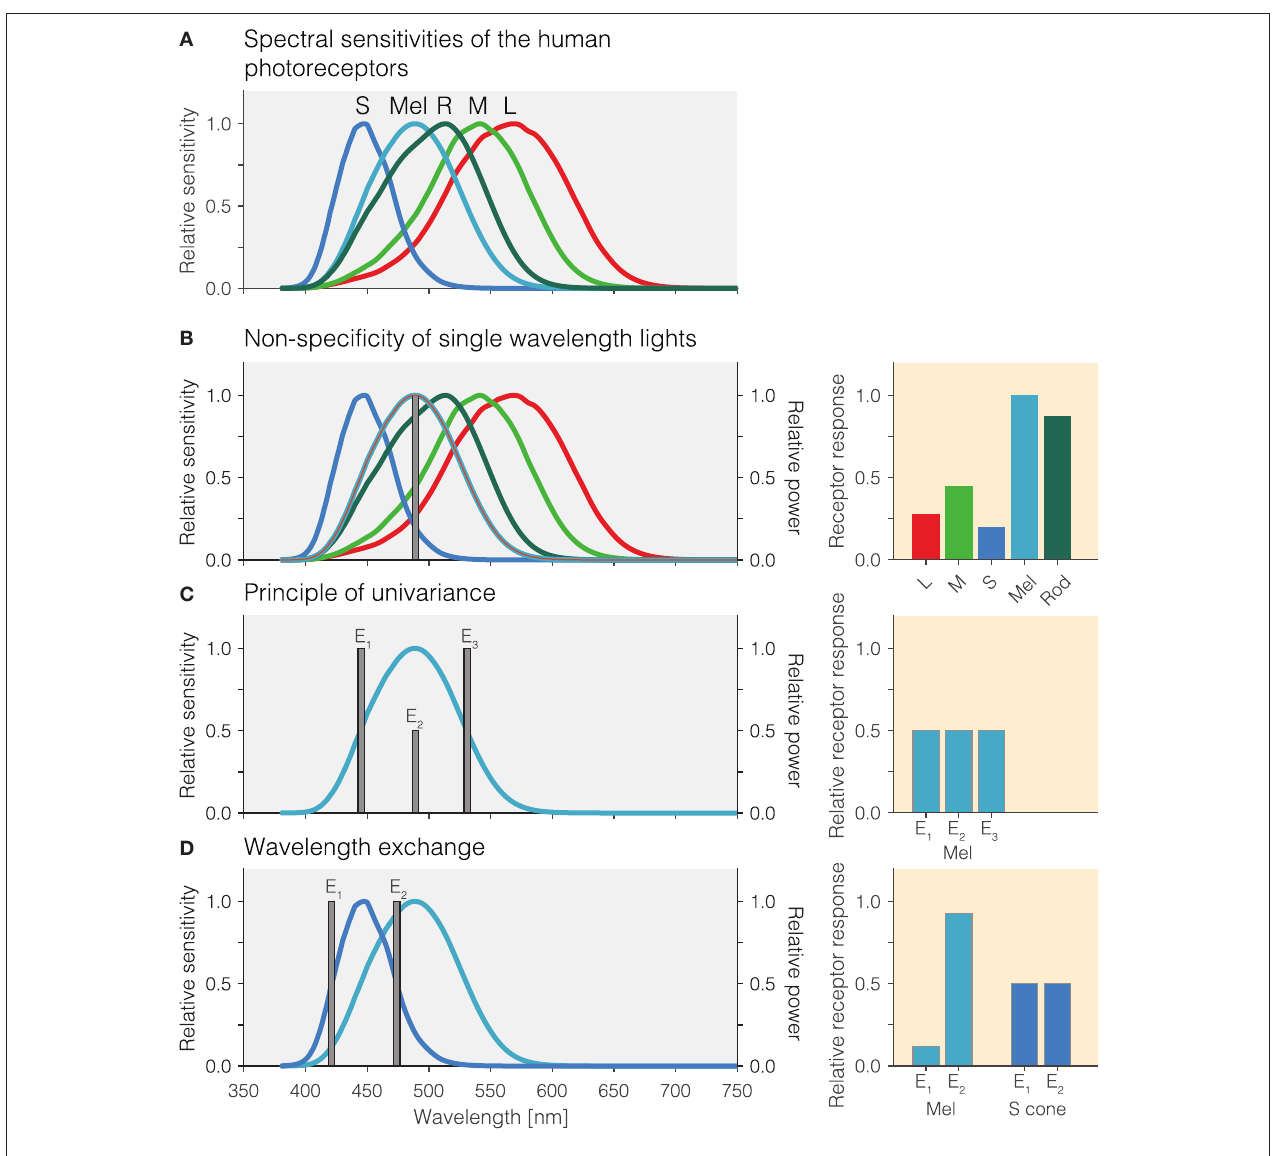
FIGURE 1 | (A) Overlapping spectral sensitivities of the human photoreceptors. (B) Non-specificity of single-wavelength lights. Right panel: Pattern of photoreceptor responses to the single-wavelength light at 490nm. (C) Principle of univariance. Right panel: Pattern of photoreceptor responses to the single-wavelength lights E 1 , E 2 , and E 3 designed to elicit the same response in melanopsin. (D) Wavelength exchange between two short-wavelength lights E 1 and E 2 which stimulate S cones at the same level but yield different photoreceptor responses for melanopsin. Right panel: Pattern of excitations for lights E 1 and E 2